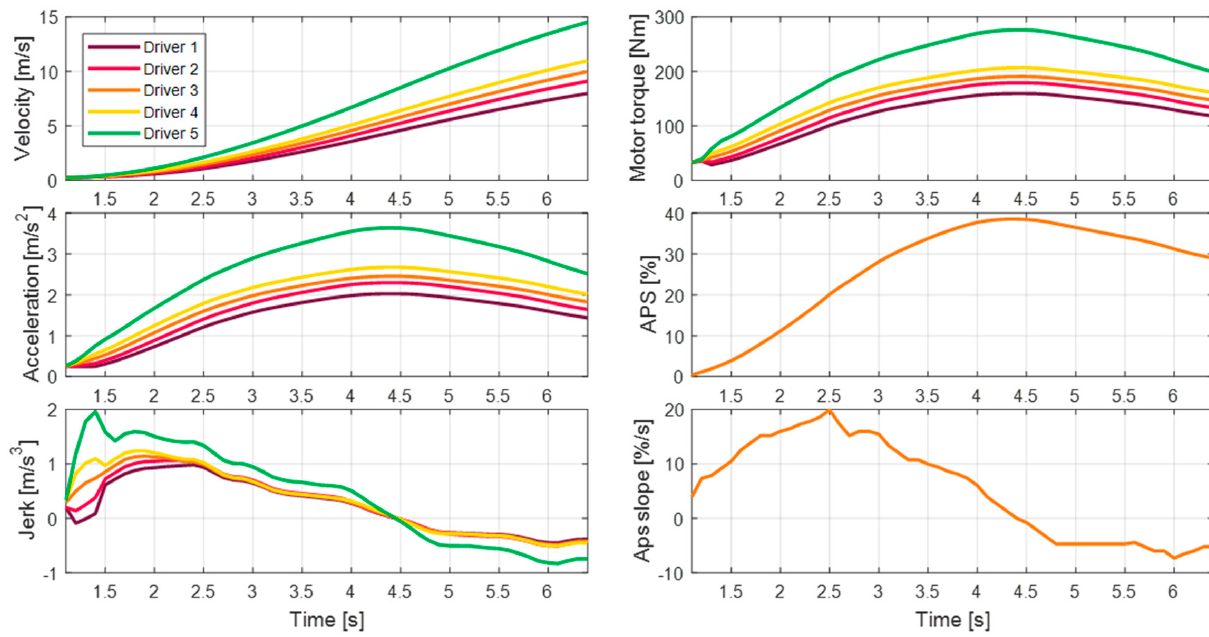
Figure 13. Acceleration behavior by target torque personalization for identical APS profiles.